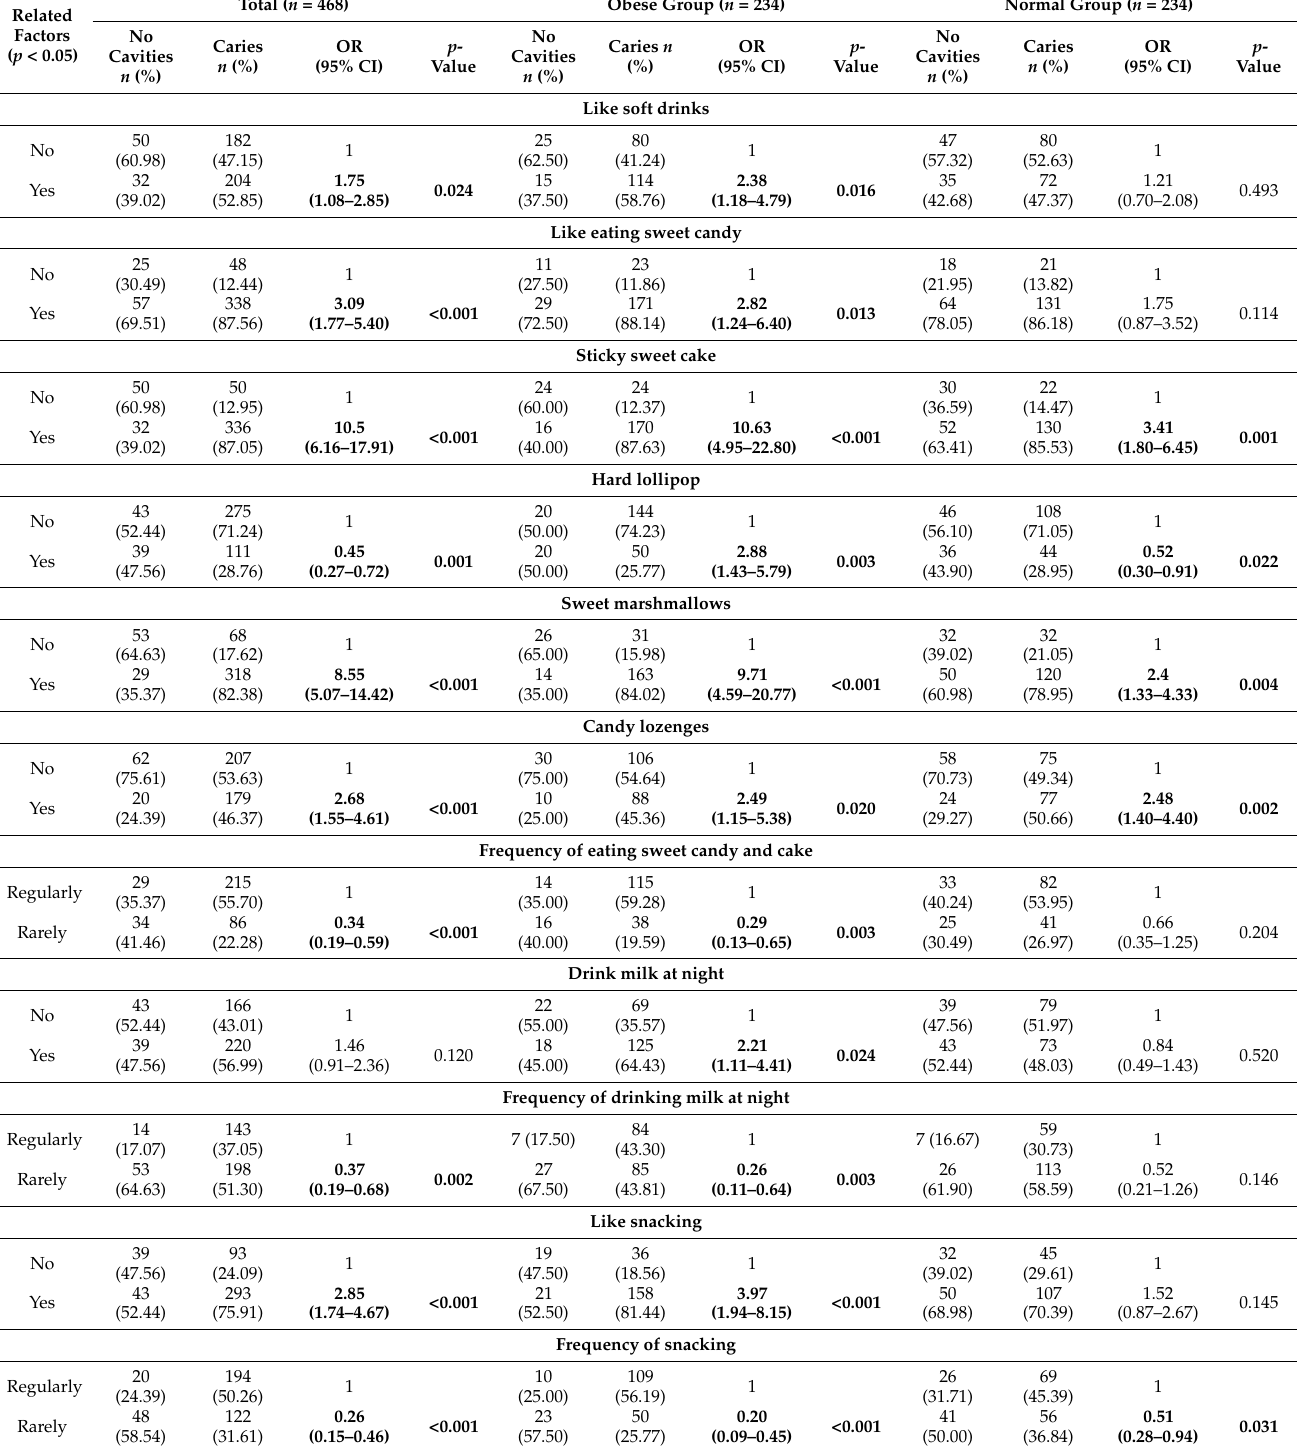
Table 2. Related factors in the univariate regression